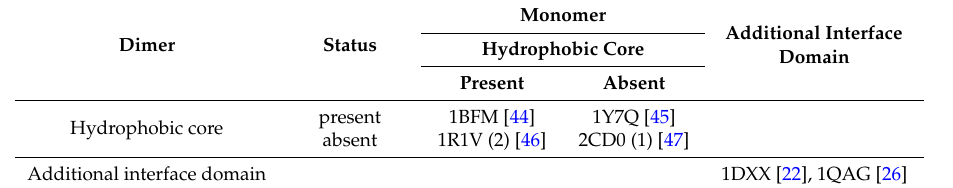
Table 1. Complexes subject to analysis in the presented work. Columns indicate the status of the hydrophobic core in each monomer while rows correspond to the status of the shared (dimeric) core. Numbers in parentheses represent the number of monomers which exhibit accordance with the idealized hydrophobic core model. The rightmost column lists two proteins which contain an emergent quasi-domain, comprised of fragments contributed by each monomer and possessing its own hydrophobic